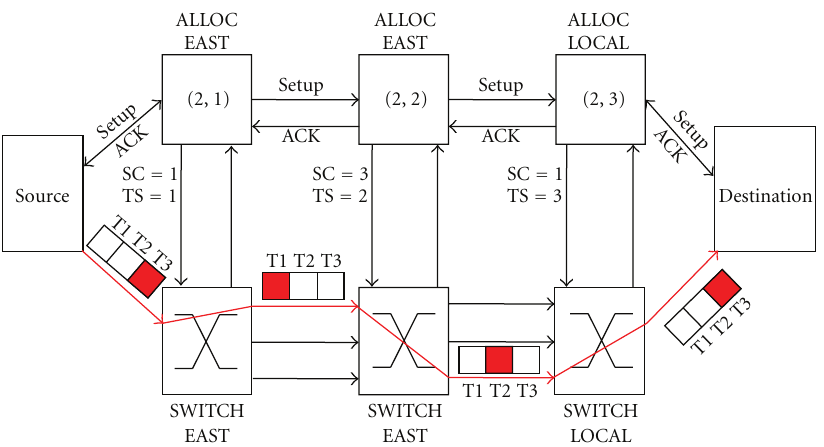
Figure 16: SDM-TDM path between source (2,1) and destination (2,3).